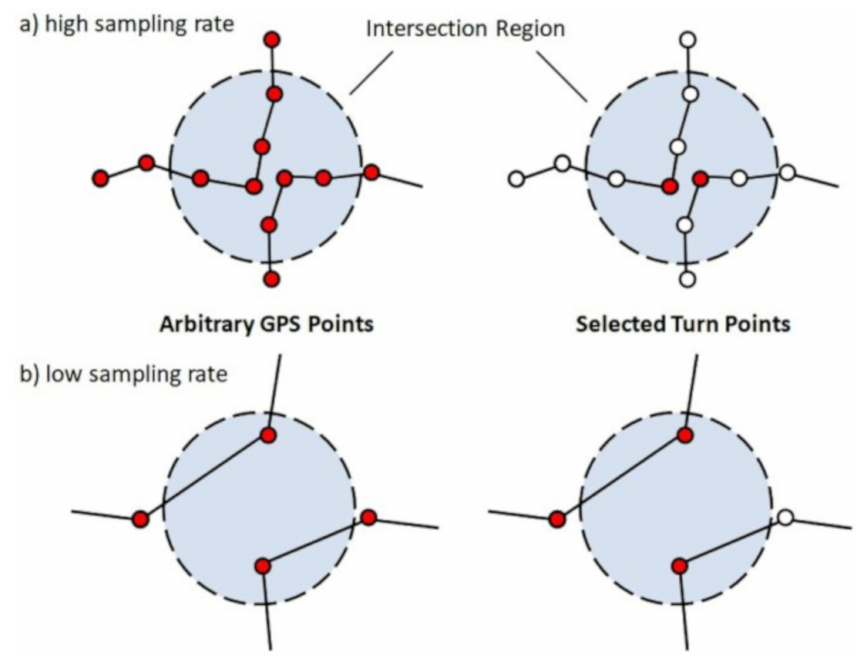
Figure 3. Turn-point’s ability to indicate a road intersection.